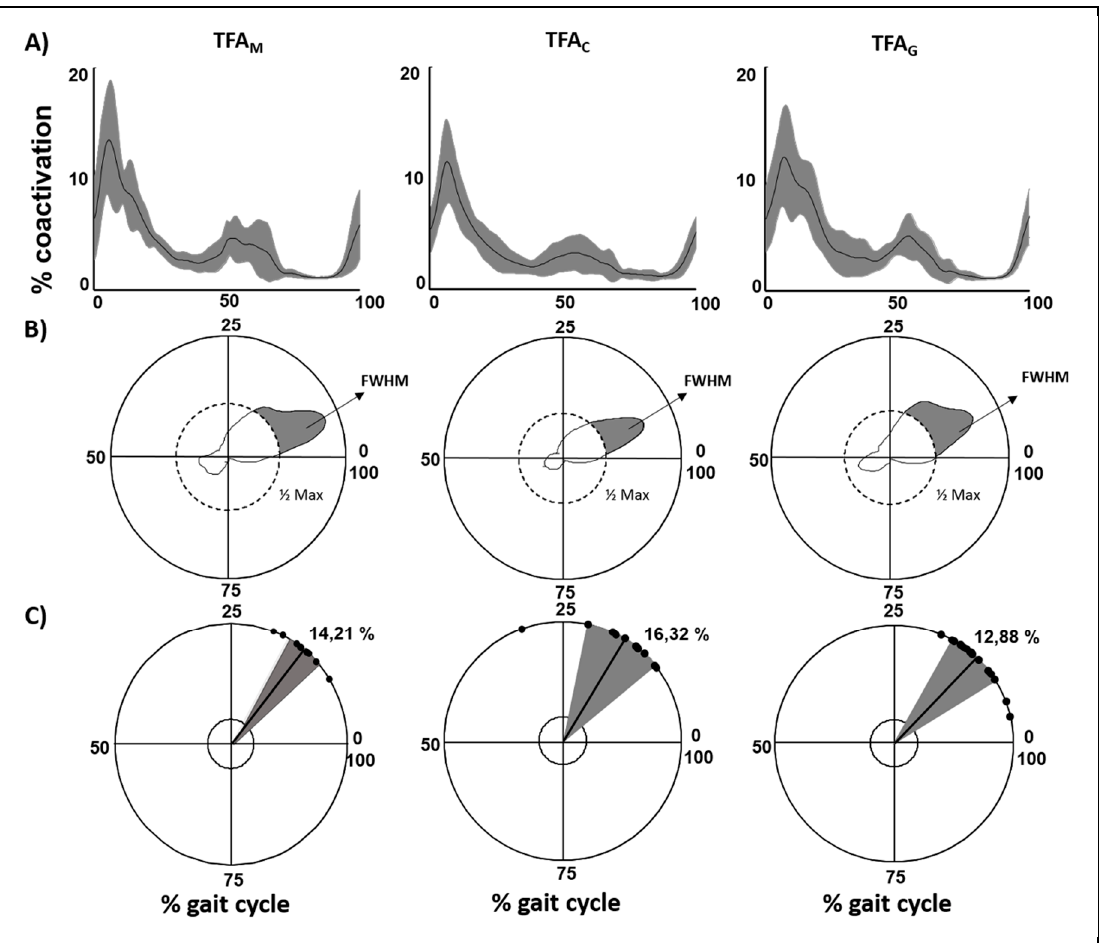
Figure 3. ( A ) TMCf curves shown as mean curves with standard deviations for people with transfemoral amputation with mechanical (TFA M ), CLeg (TFA C ), and Genium prostheses (TFA G ). ( B ) Full width at half maximum (FWHM) of the TMCf for each group shown in polar coordinates. ( C ) Center of activity (CoA) of the TMCf for each group: each dot represents the mean CoA value of a subject, whereas the solid line and the width of the circular sector represent the mean and standard deviation values of the CoA of all subjects, respectively. All parameters are shown as percentages of the gait cycle.